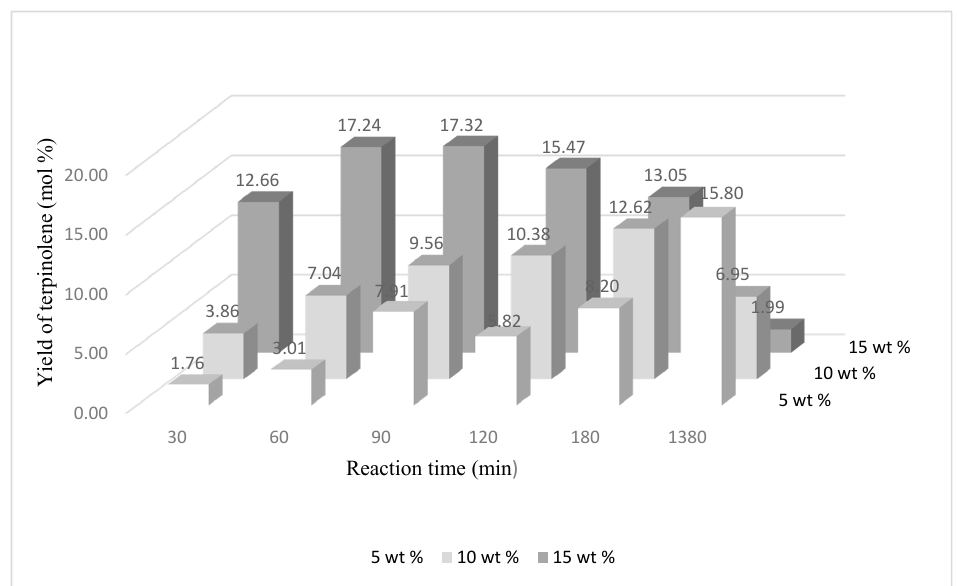
Figure 5. Influence of the amount of catalyst and the reaction time on the yield of terpinolene, for the reaction carried out at 160 °C. The amount of catalyst was 5, 10, or 15 wt %, and the reaction time was 30, 60, 90, 120, 180, or 1380 min.